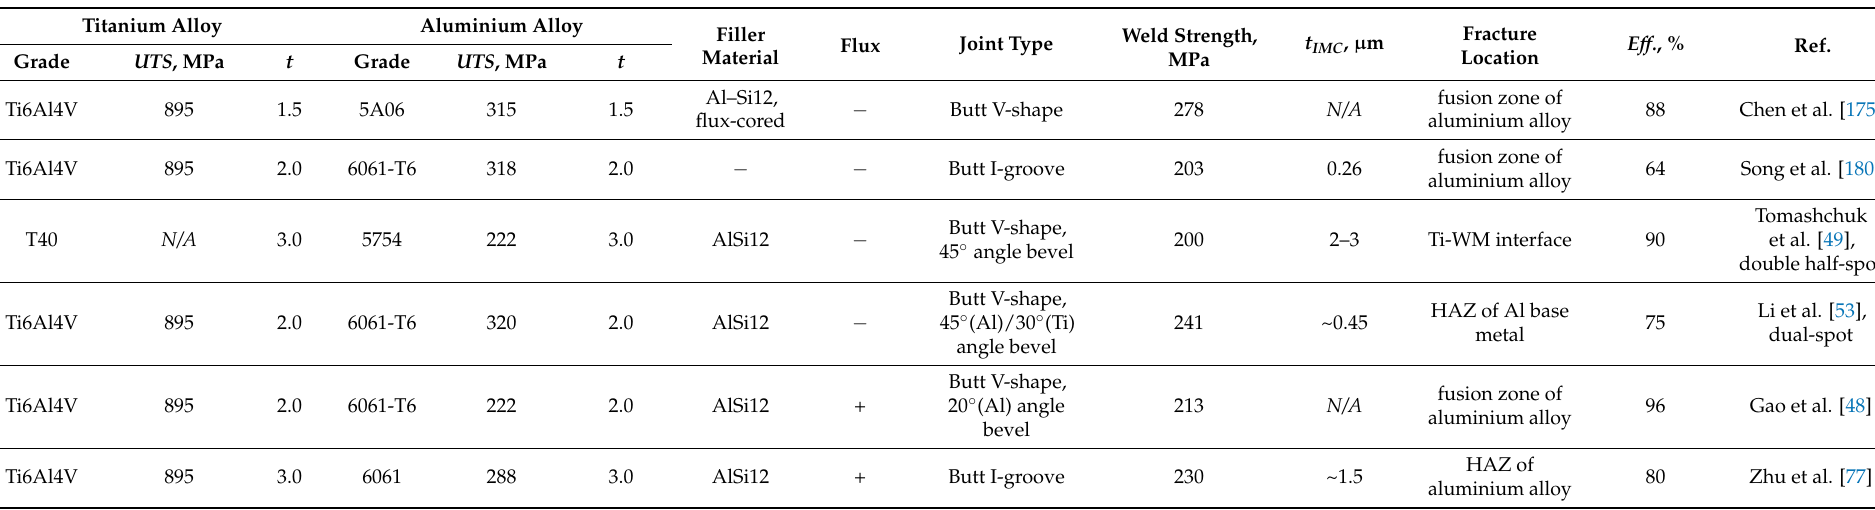
Table 8. Strength of welds between titanium and aluminium alloys by using laser beam and laser-assisted hybrid welding–brazing. Abbreviations: t is thickness is specimen (in mm), UTS is ultimate tensile strength, t IMC is thickness of IMC layer, if flux was used (+) or was not ( − ). Efficiency ( Eff. ) means the strength of joint comparable to aluminium alloy BM strength. Indicated weld strength is max. achieved strength under certain (optimised) welding conditions within publication, which may contain more diversity in applied welding parameters, consumables, and